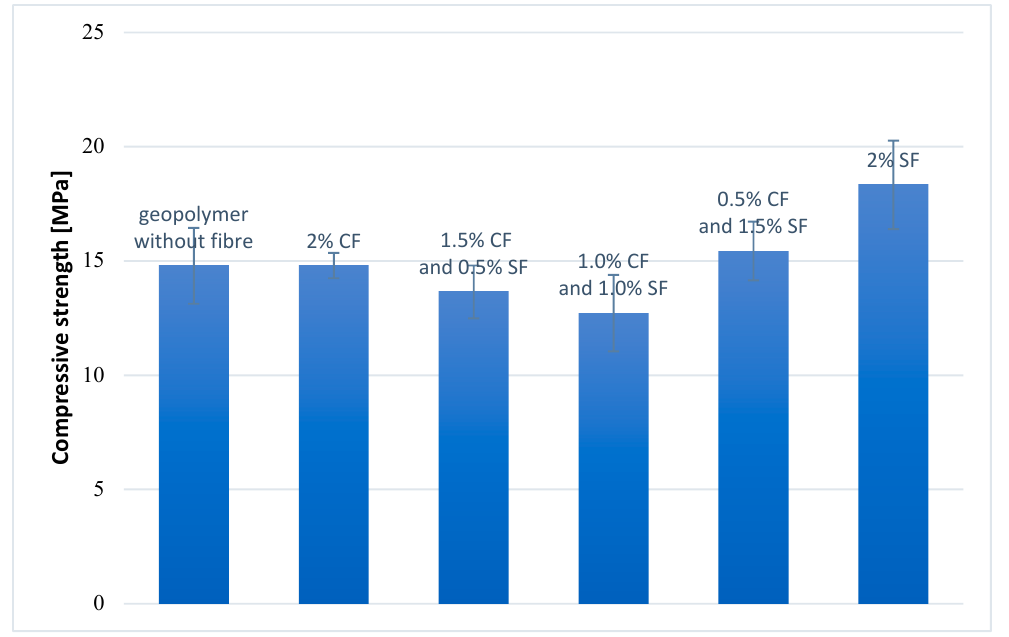
Figure 8. Compressive strength of geopolymer composites.